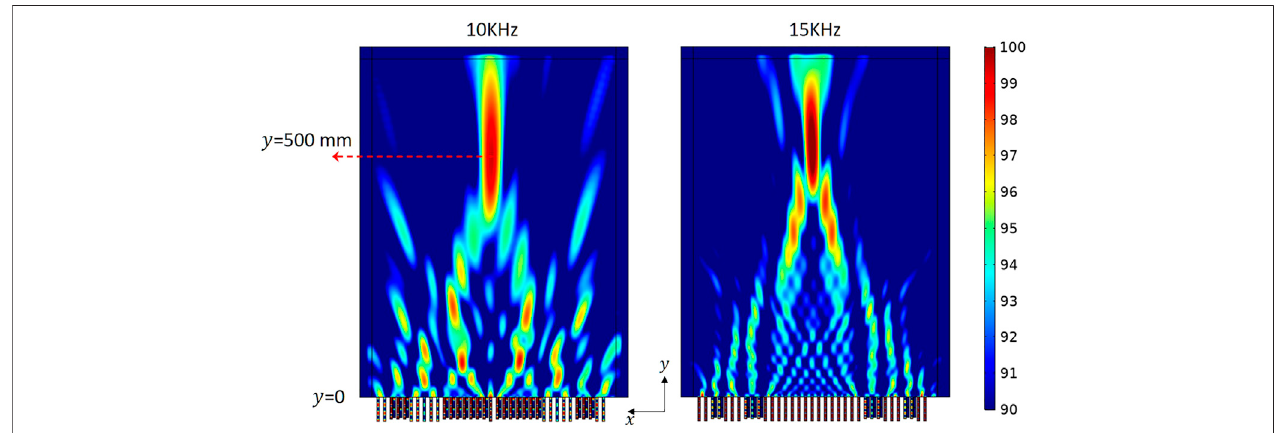
FIGURE4| Simulation ofwavefocusingat 10 KHzand15 KHz.Theincidentwaveisaplanewavetravellinginthe-ydirection.Themetasurfacesinboth casesare formed by35equally spacedphase modulation elements and havethetotal sizeof480 mm inthexdirection. Thesequence fromthelefttotheright forthemetasurface at10 KHzis:(0,0, π , π , π ,0,0,0,0,0, π , π , π , π , π , π , π ,0, π , π , π , π , π , π , π ,0,0,0,0,0, π , π , π ,0,0).Thatforthemetasurfaceat15 KHzis:(0,0, π , π ,0,0,0, π , π , π ,0,0,0,0, 0, 0, 0, 0, 0, 0, 0, 0, 0, 0, 0, π , π , π , 0, 0, 0, π , π